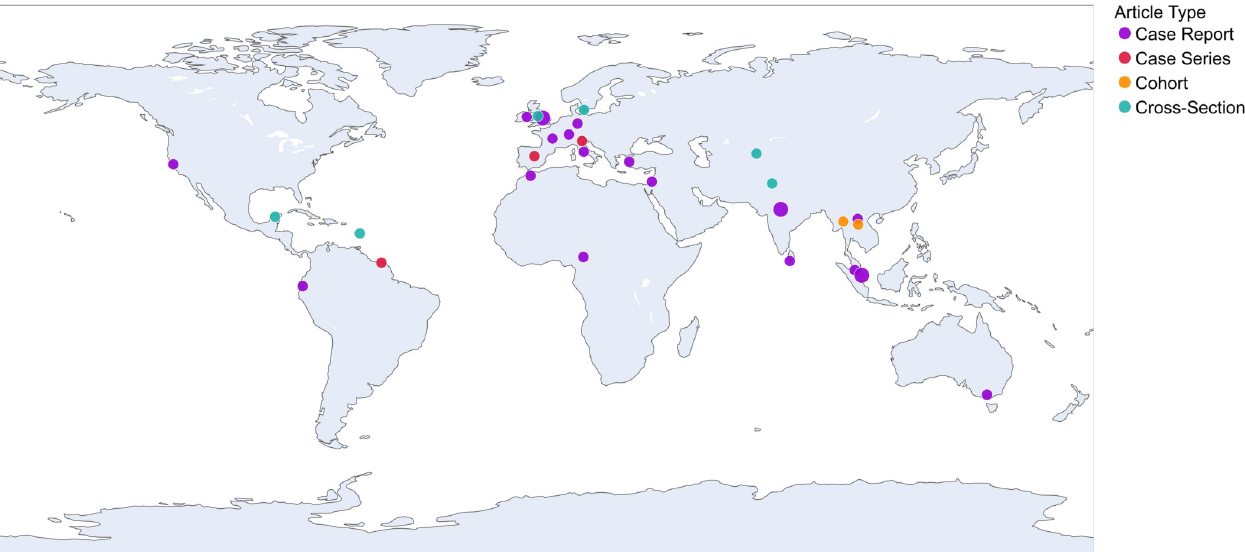
Fig 2. Geographical distribution of included published articles. The colour corresponds to the type of article (see key), and the size of the marker corresponds to the number of articles published in that country. There were no more than two articles of the same type from one country. Bubble map created with Plotly Graphing Libraries - Made with Natural Earth. Free vector and raster map data @ naturalearthdata.com.